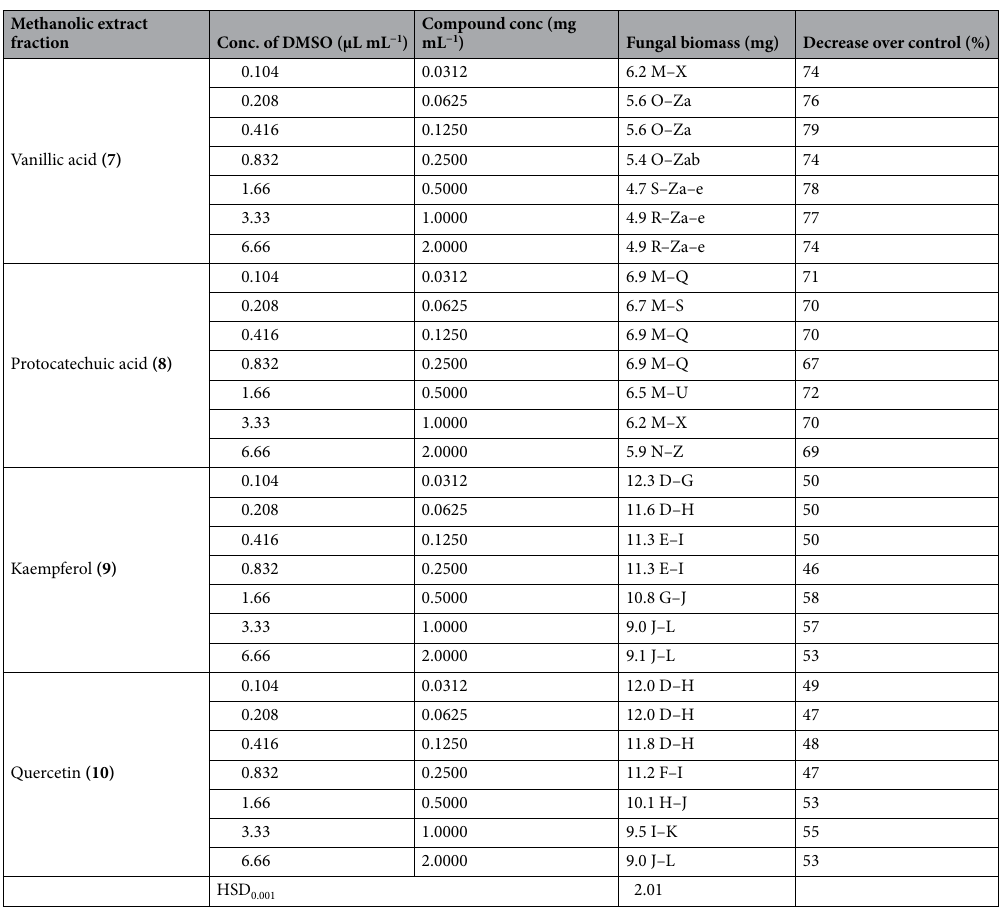
Table 1. Effect of different concentrations of fungicide mancozeb and compounds isolated from Monotheca buxifolia on growth appearance and biomass of Macrophomina phaseolina. Values with different letters in a column show significant difference (P ≤ 0.001) as determined by Tukey’s HSD